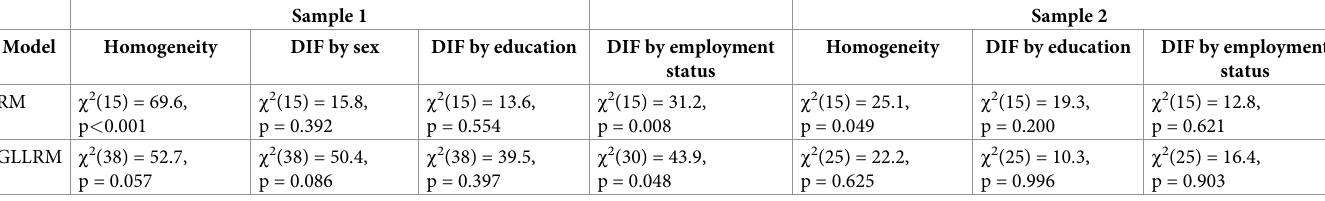
Table 2. Conditional likelihood ratio test of overall model fit and global